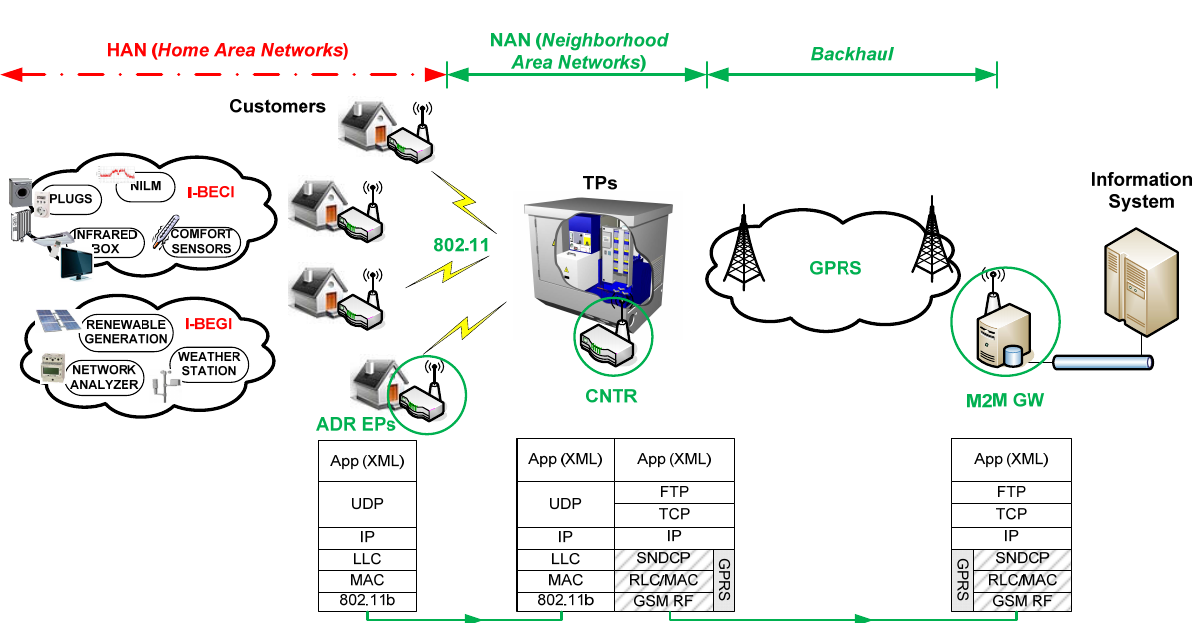
Figure 9. Mapping of the proposed M2M communications architecture onto the power distribution